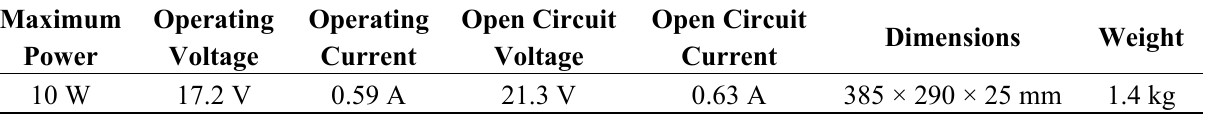
Figure 16. DFY-2 Radiometer. Table 1. Solar panel variables.